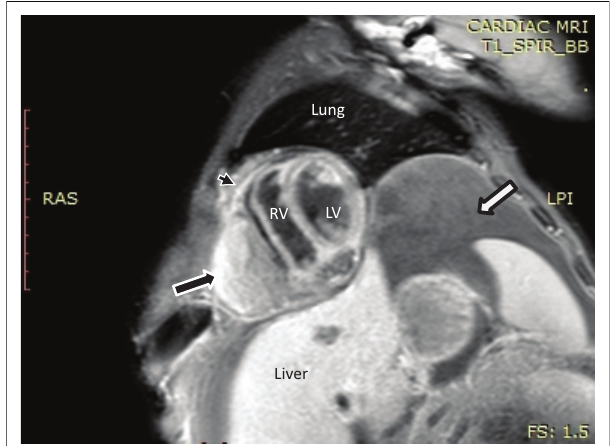
FIGURE 1: Short axis post contrast T1 spectral presaturation inversion recovery black blood sequence showing a high signal mass lesion (black arrow) with an associated nodular pericardium (black arrowhead) and massive ascites (white